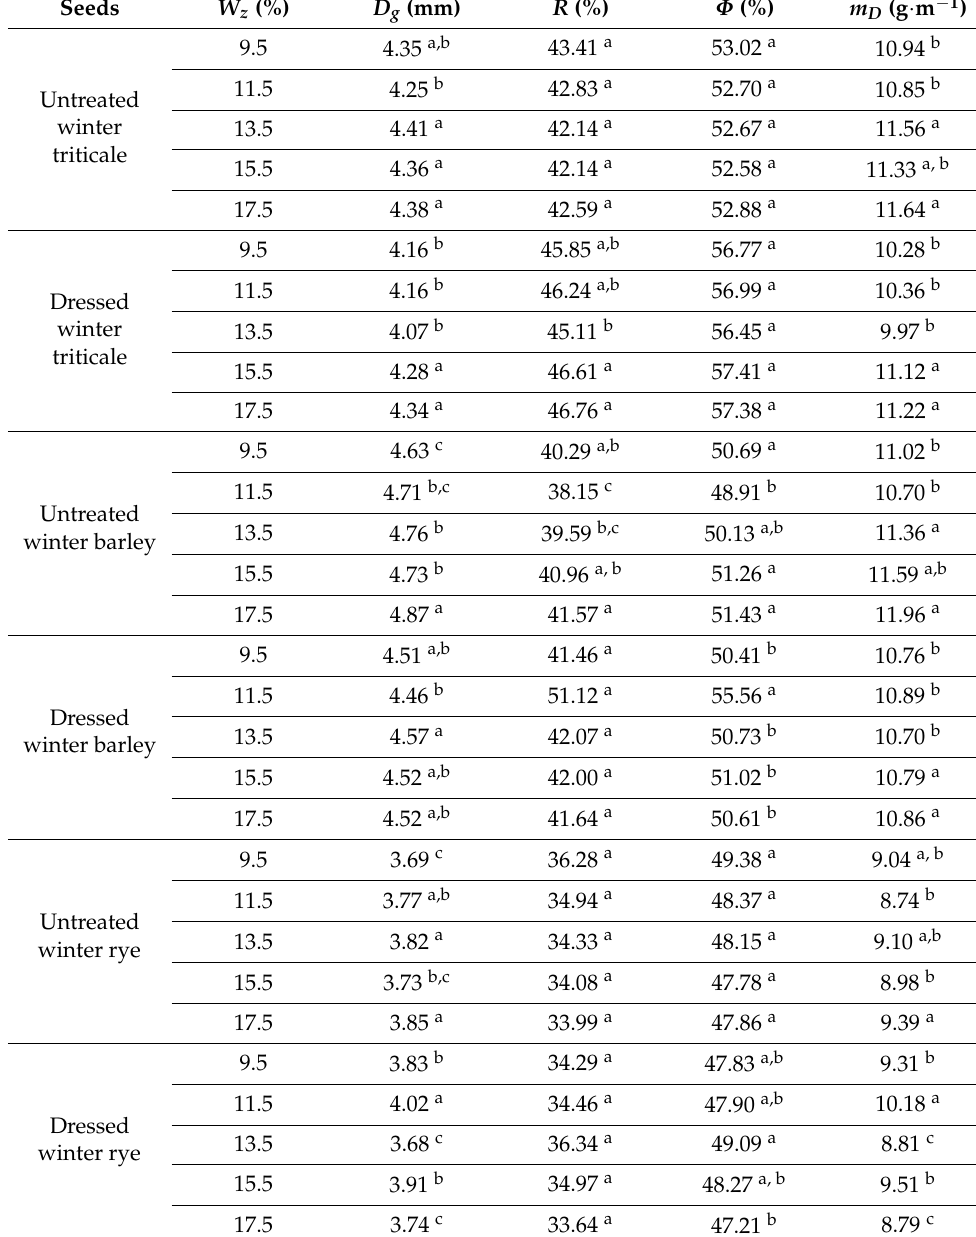
Table 4. The mean values of the indexes of the cereal